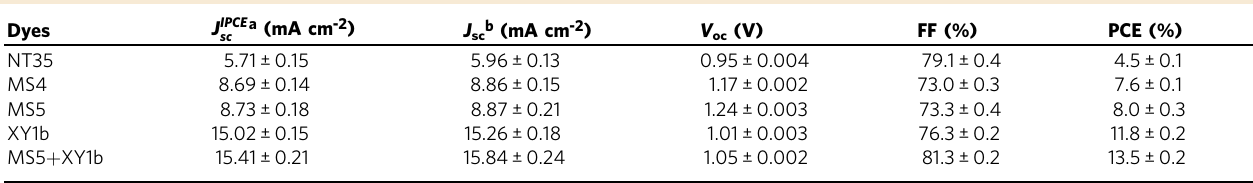
charge recombination from trap states.